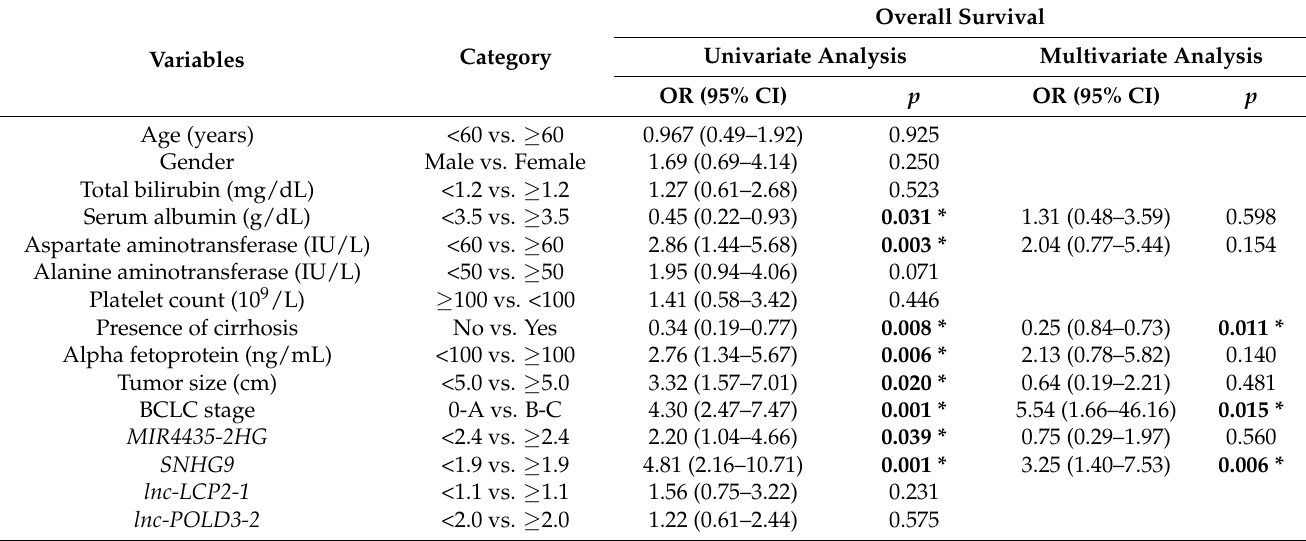
Table 3. Variables associated with overall survival in patients with